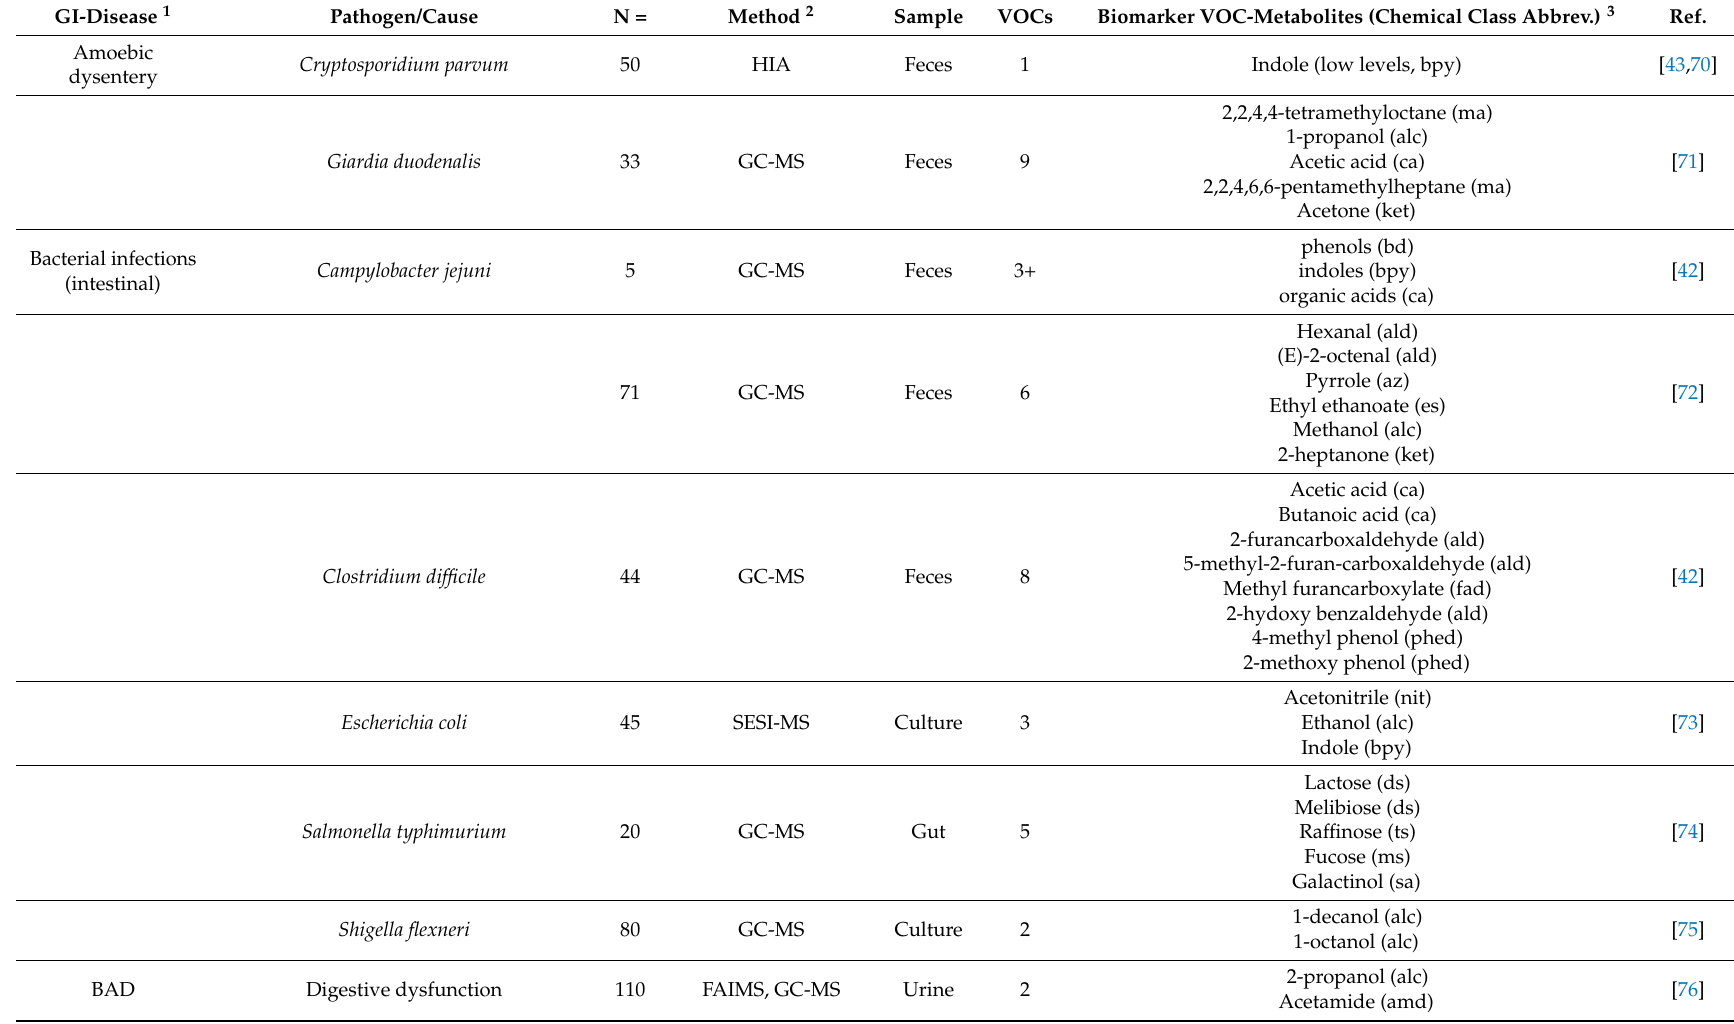
Table 3. Biomarker VOC-metabolites discovered with potential application for noninvasive early diagnosis of gastrointestinal (GI)